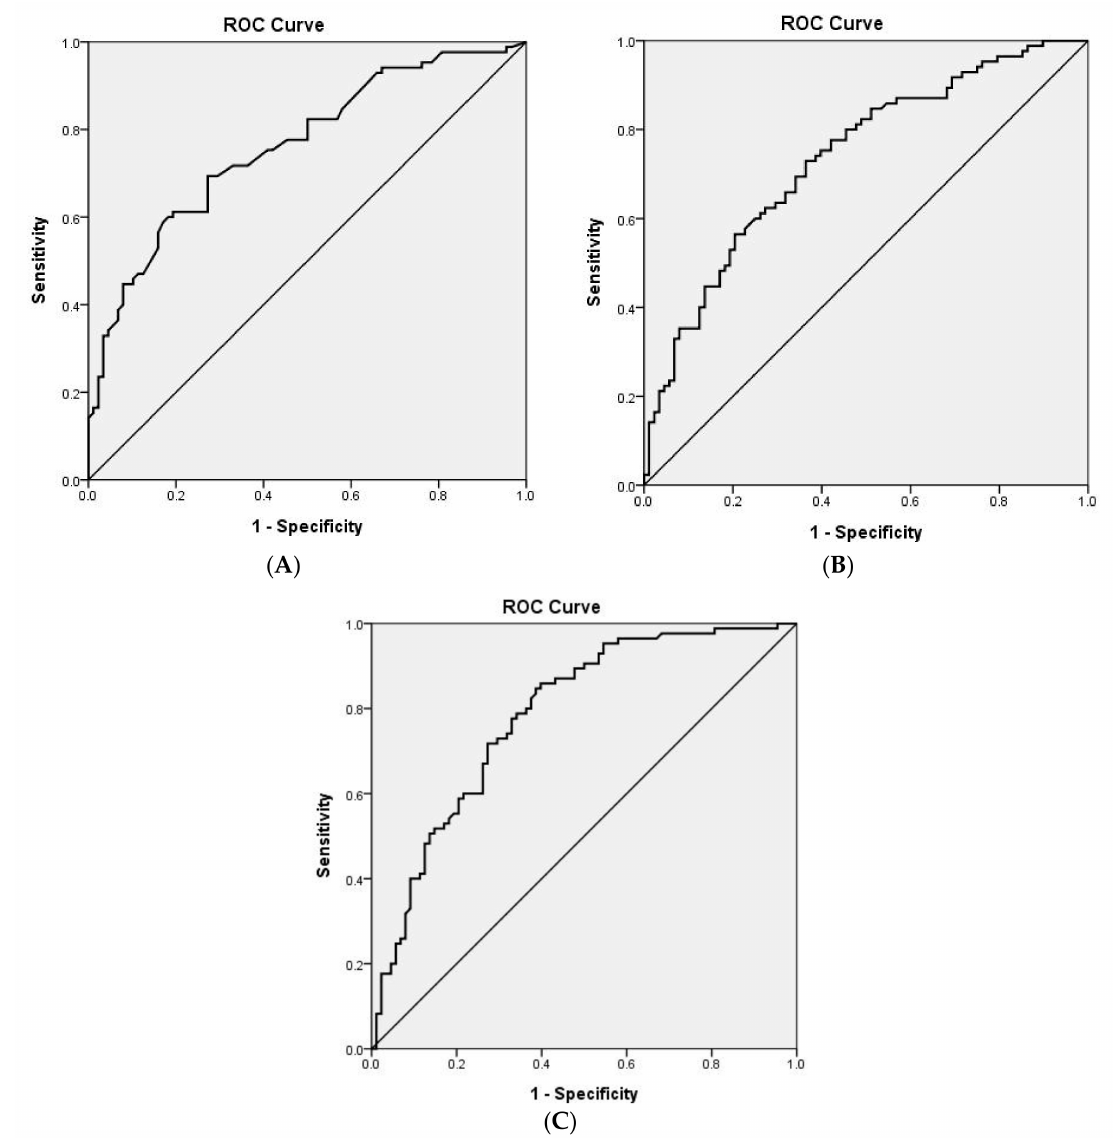
Figure 2. ROC curve analysis of the predictive factor for MVI in HCC. The area under curve of the largest tumor diameter ( A ), ADC mean ( × 10 − 3 mm 2 /s) ( B ), ADC min ( × 10 − 3 mm 2 /s) ( C ), were 0.76, 0.74, and 0.79 respectively, p value < 0.05. The cut-off value was 3 cm for the largest single tumor, 1.38 × 10 − 3 mm 2 /s of ADC mean and 0.95 × 10 − 3 mm 2 /s of ADC min